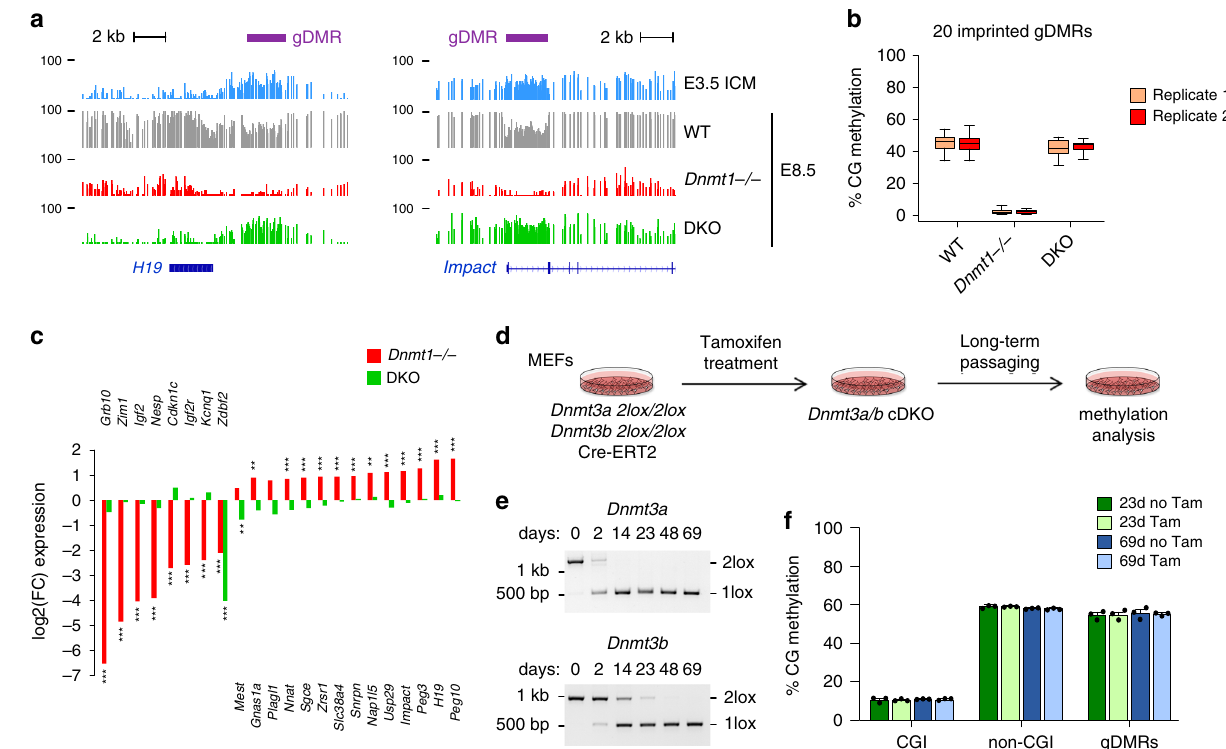
Fig. 3 Role of DNMTs in methylation imprints and maintenance methylation. a Genome browser tracks of WGBS methylation pro fi les at the H19 and Impact imprinted loci in early embryos and Dnmt mutant embryos. One WGBS replicate is shown. The positions of the imprinted germline DMRs (gDMRs) are depicted by purple rectangles. b Boxplots of the CG methylation levels of n = 20 imprinted germline DMRs measured by WGBS in WT, Dnmt1 − / − and DKO embryos. In the boxplots the line indicates the median, the box limits indicate the upper and lower quartiles and the whiskers extend to 1.5 IQR from the quartiles. c Fold change of expression of imprinted genes in Dnmt1 − / − (red bars) and DKO (green bars) embryos ( n = 3 embryos for Dnmt1 − / − ; n = 6 embryos for DKO). ** p < 0.01; *** p < 0.001 (adjusted p value calculated by DESeq2 using a Wald test corrected for multiple testing). d Experimental outline for investigating the maintenance function of DNMT3A/B in MEFs. Dnmt3a 2lox/2lox Dnmt3b 2lox/2lox immortalized MEFs expressing Cre-ERT2 were treated with Tamoxifen to generate conditional double knockout (cDKO) cells, and methylation was quanti fi ed by RRBS after long-term passaging. e Evaluation by PCR genotyping of the Cre-mediated recombination of the Dnmt3a and Dnmt3b -2lox alleles in cDKO fi broblasts. The number of days of Tamoxifen treatment is indicated above the gels. f CG methylation levels quanti fi ed by RRBS in cDKO fi broblasts. The graph shows the methylation levels in CpG islands (CGI), non-CGI regions, and imprinted gDMRs in cells treated with Tamoxifen (Tam) or not treated with Tamoxifen (no Tam) after 23 and 69 days of culture (mean ± SEM, n = 3 biological replicates), revealing no global hypomethylation in cDKO MEFs. Source data are provided as a Source data fi